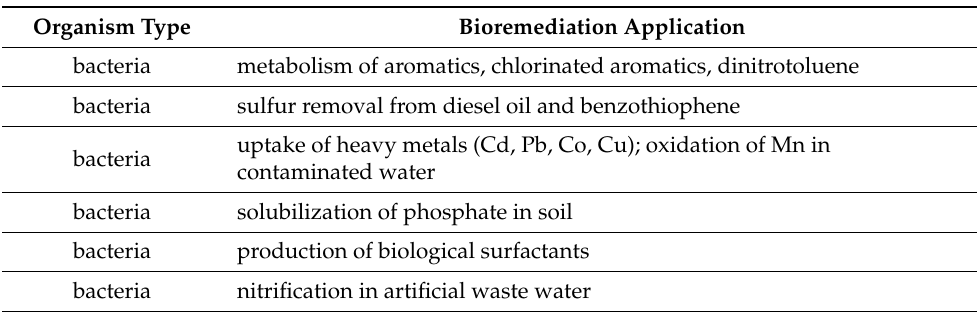
Table 3. Applications of engineering of bacteria with vgb in bioremediation and waste water treatment. Further information can be found in references